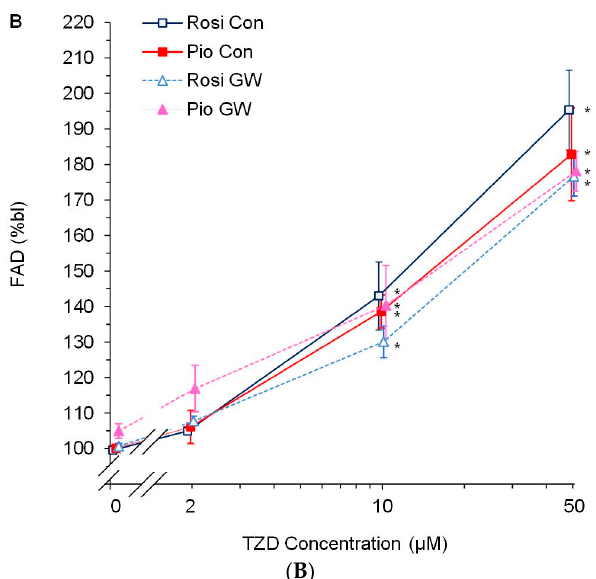
Figure 3. Shows a concentration-dependent decrease in autofluorescence of reduced NADH (Panel ( A )) and a concomitant concentration-dependent increase in autofluorescence of oxidized FAD (Panel ( B )) with administration of the thiazolidinediones (TZDs) rosiglitazone (Rosi, open dark-blue square) and pioglitazone (Pio, closed red square) compared to % baseline (bl). The PPAR γ antagonist GW9662 (GW, 10 µM) did not alter the effect of rosiglitazone (open light-blue triangle) or pioglitazone (closed pink triangle) on NADH (Panel ( A )) or FAD (Panel ( B )) at any of the concentrations. Statistics: ANOVA followed by SNK post-hoc test with P < 0.05 (two-tailed) vs. * 0 µM TZD; n = 6 per group. Please note that the slight horizontal offset of curves for any given concentration is for visual purposes only.